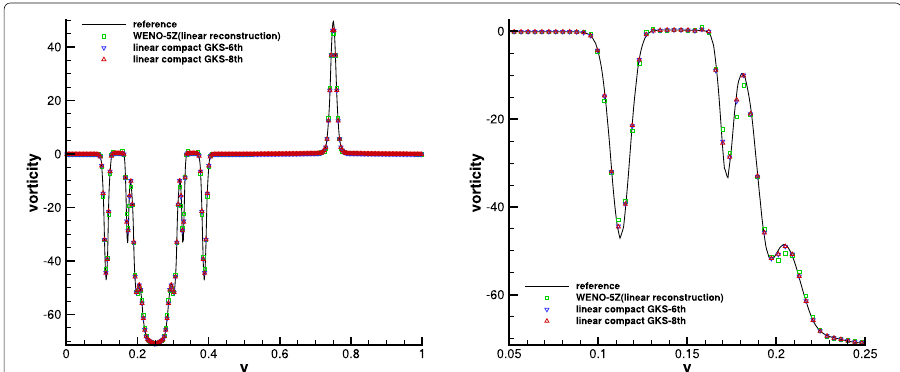
Fig. 24 Double shear flow: vorticity distribution and local enlargement at the line x = 0.5 obtained by 5th-order upwind scheme, linear 6th-order and 8th-order compact GKS at t = 0.8 with 256 × 256 mesh points. The reference solution is obtained by linear 8th-order compact GKS with 512 × 512 mesh points